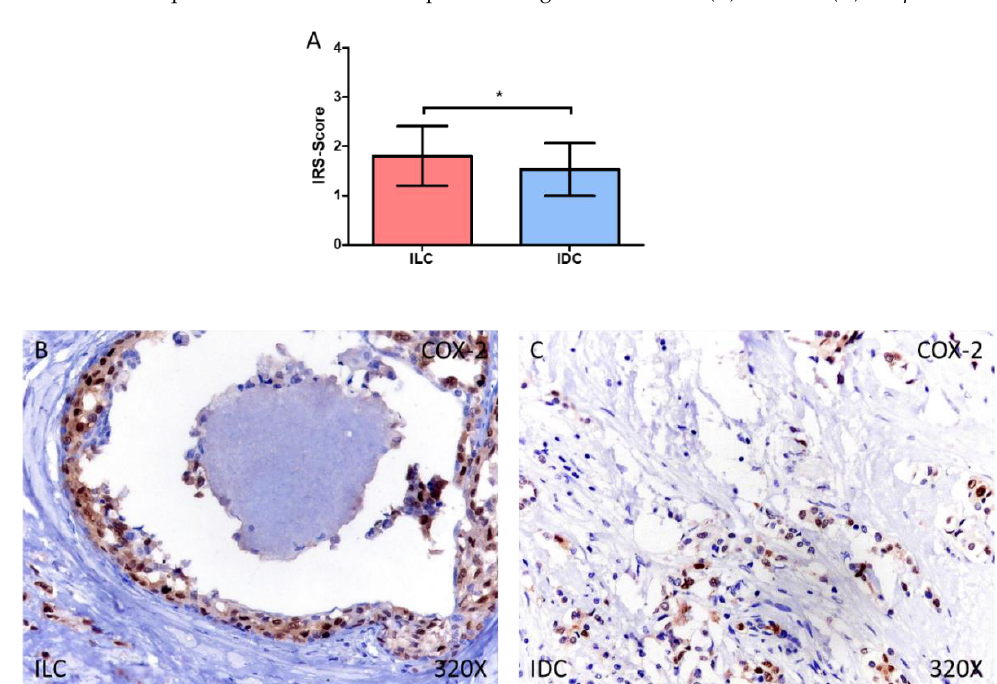
Figure 2. ( A ) IRS-Score for COX-2 in patients diagnosed with invasive lobular carcinoma (ILC) and infiltrative ductal carcinoma (IDC). ( B , C ) Histological images of COX-2 expression using immunohistochemical techniques in the breast tissue of patients diagnosed with ILC ( B ) and IDC ( C ). * p < 0.05.